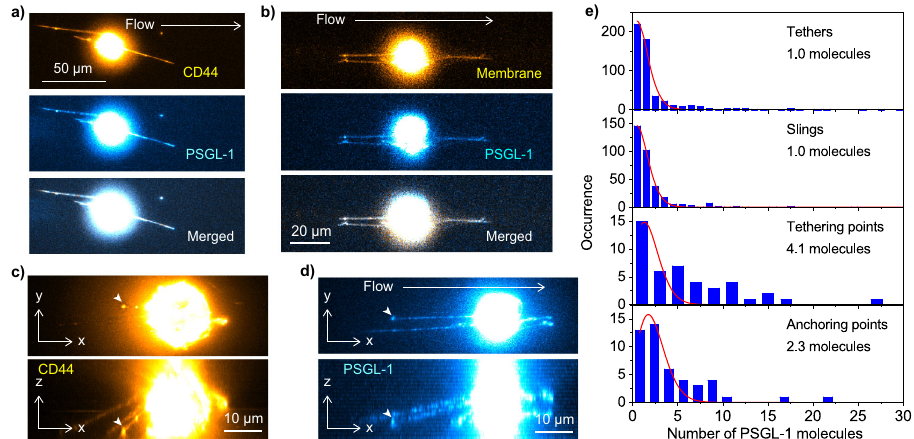
Fig. 4 Spatial clustering of the selectin ligands at the tethering and anchoring points. a Two-color fl uorescence image of CD44 (top, yellow, immunostained by Alexa-Fluor-647-conjugated anti-CD44 antibody) and PSGL-1 (middle, cyan, immunostained by Alexa-Fluor-488-conjugated anti- PSGL-1 antibody) captured during the KG1a cell rolling over E-selectin. The merged image is displayed in the bottom panel. b Two-color fl uorescence images of the cell membrane (top, yellow, stained by Vybrant DiO dye) and PSGL-1 (middle, cyan, immunostained by Alexa-Fluor-647-conjugated anti- PSGL-1 antibody,) captured during the KG1a cell rolling over the surface-deposited E-selectin molecules. The merged image is displayed in the bottom panel. c , d Top view (top) and side view (bottom) of the 3D reconstructed fl uorescence images of the ( c ) CD44 molecules (immunostained by Alexa- Fluor-647-conjugated anti-CD44 antibody) and ( d ) PSGL-1 molecules (immunostained by Alexa-Fluor-555-conjugated anti-PSGL-1 antibody) captured during the KG1a cells rolling over E-selectin. The 3D images were reconstructed by recording fl uorescence images of the cell at 59 different Z -axis positions with 0.5 μ m step size and 40 different Z -axis positions with 1 μ m step size for CD44 and PSGL-1, respectively. e Frequency histograms of the number of the PSGL-1 molecules in each spot on the tethers and slings and at the tethering points and anchoring points of the KG1a cells. The solid lines show Poissonian fi ttings. All the fl uorescence images of the rolling cells were captured by injecting KG1a cells into the rh E-selectin-deposited micro fl uidic chambers at a shear stress of 2 dyne cm − 2 (0.2